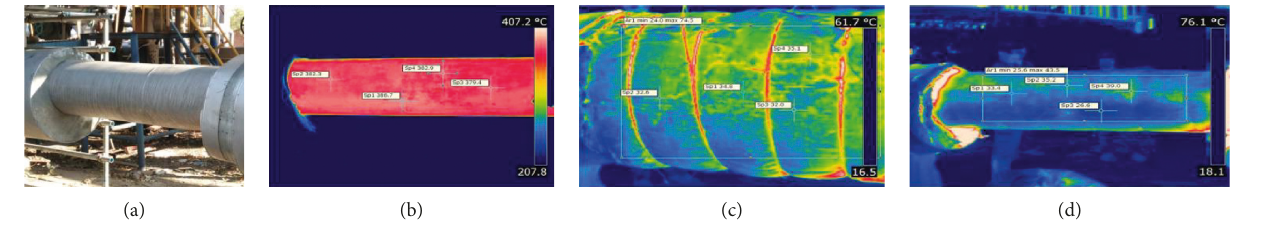
Figure 7: Contrast of infrared imaging with the rock wool panel and AB as insulation materials (source: [31]). (a) Pipe photo, (b) infrared thermal imaging of the pipe, (c) rock wool panel as the insulation layer, and (d) AB as the insulation layer.